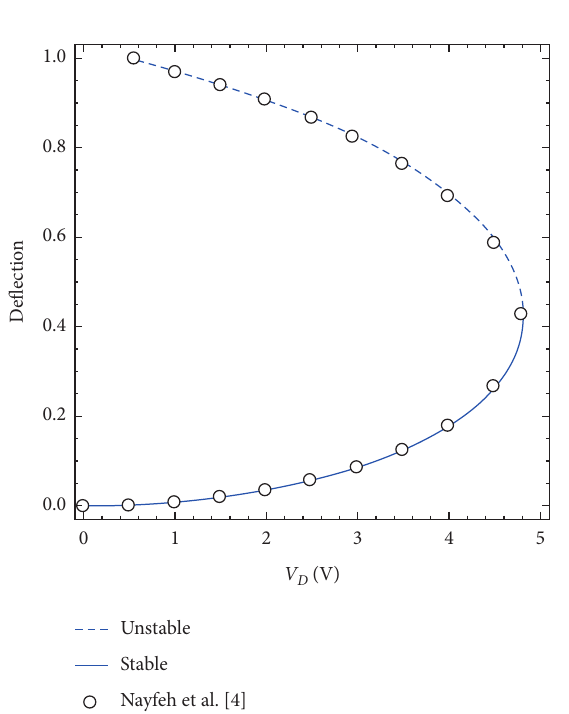
Figure 2: Maximum static deflection of a microbeam-based